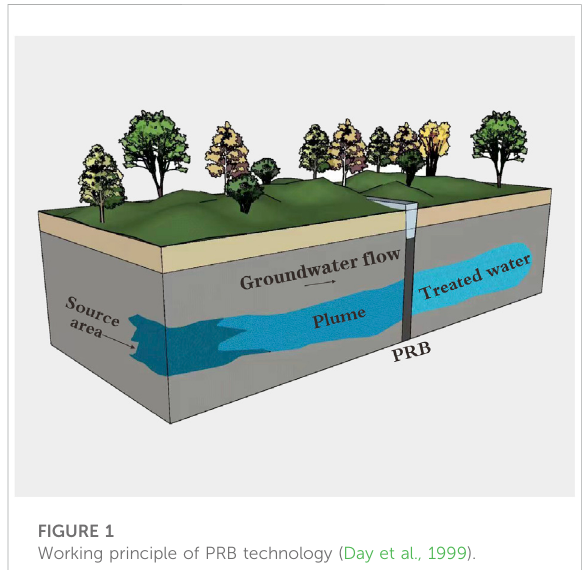
FIGURE 1 Working principle of PRB technology (Day et al.,